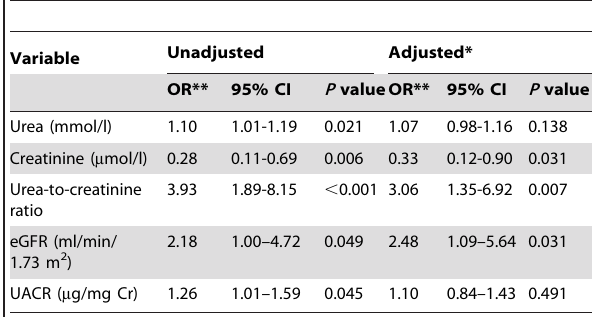
Table 2. The association of biochemical renal parameters with LVDD and severity of LVDD.